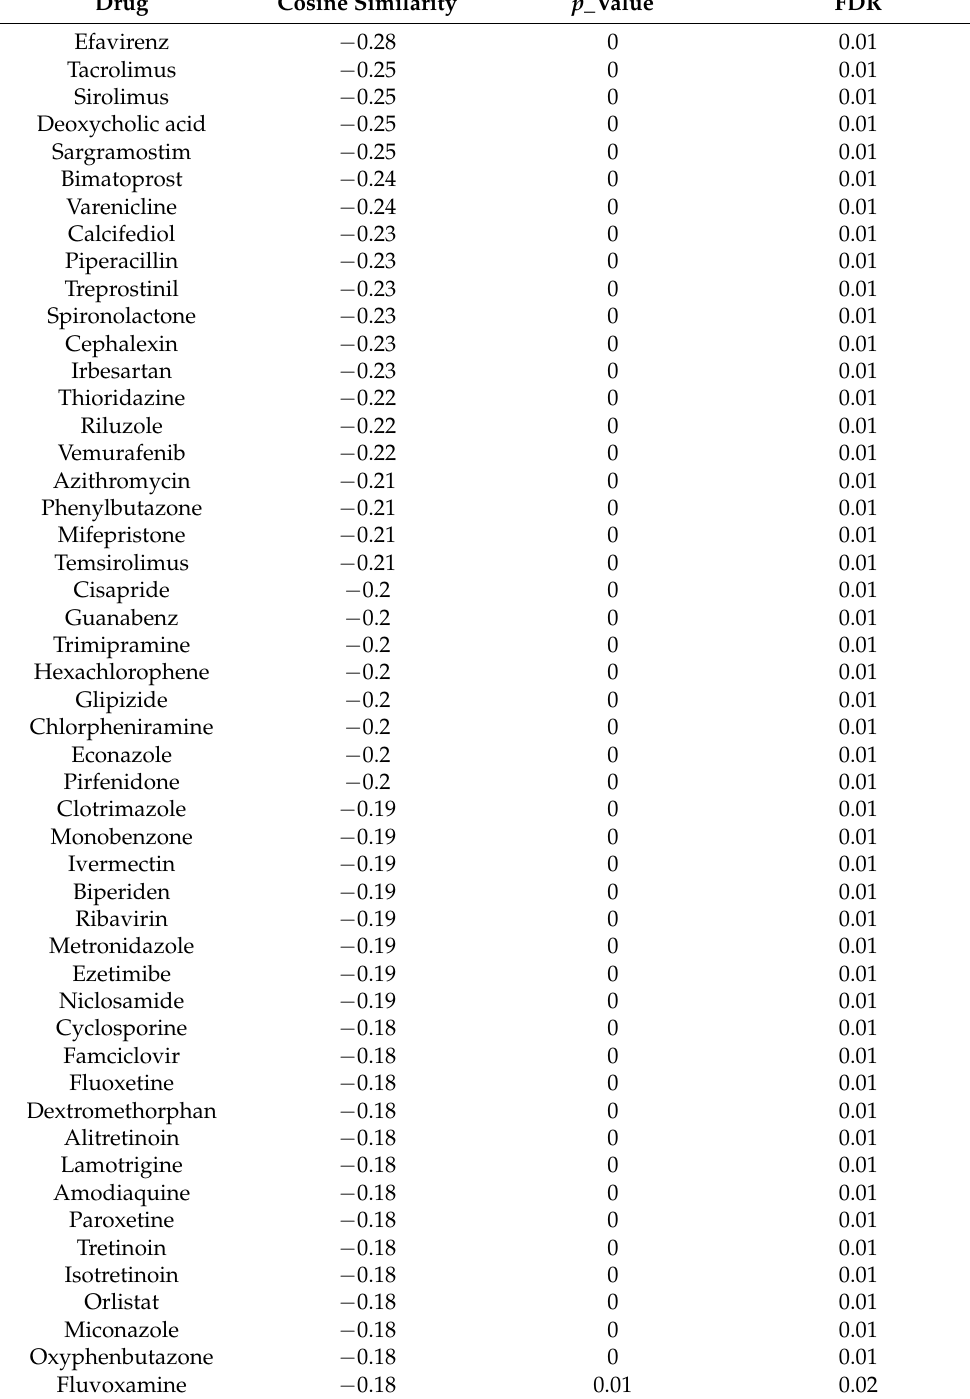
Table 3. Top 50 predicted drugs.